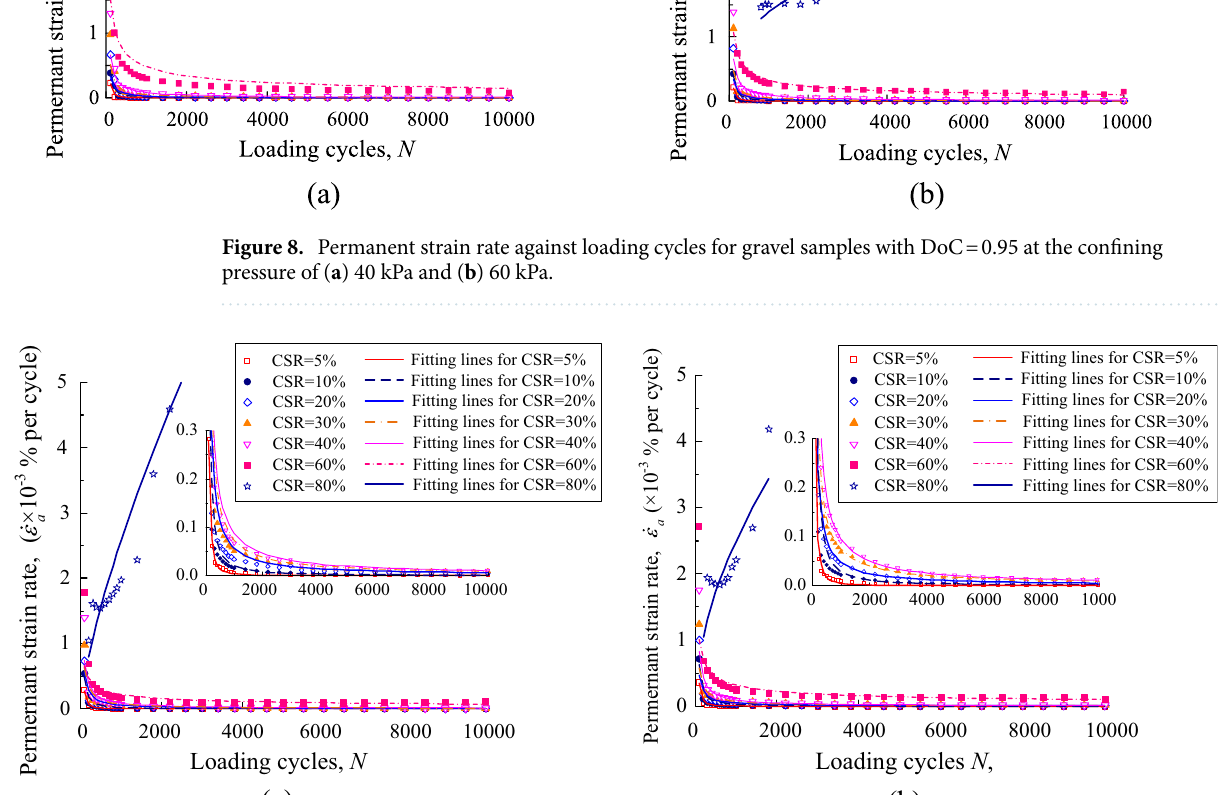
Figure 9. Permanent deformation rate against loading cycles for gravel samples with DoC = 1.00 at the confining pressure of ( a ) 40 kPa and ( b ) 60